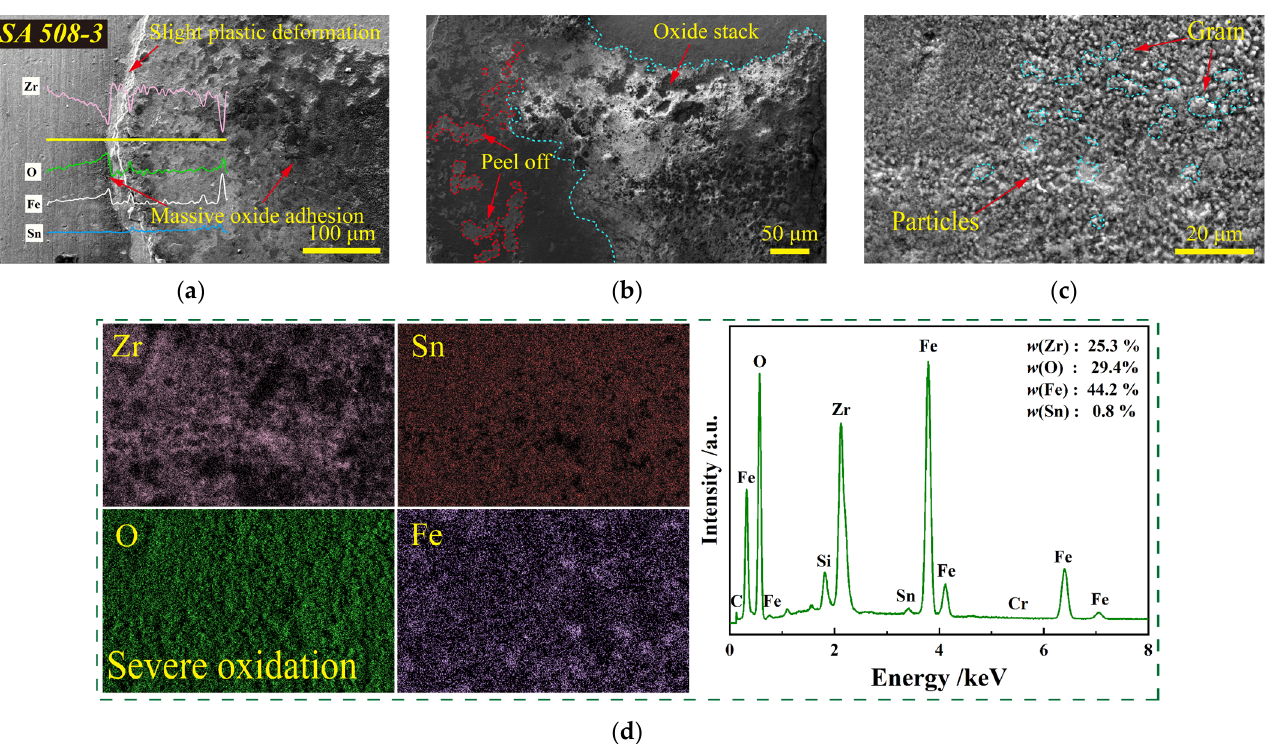
Figure 13. SEM micrographs of wear scar and EDS after being cyclically impacted by the SA508−3 impact block 500,000 times. ( a ) Line scan spectrum; ( b ) oxide stack; ( c ) granular wear debris; ( d ) wear debris spectrum.